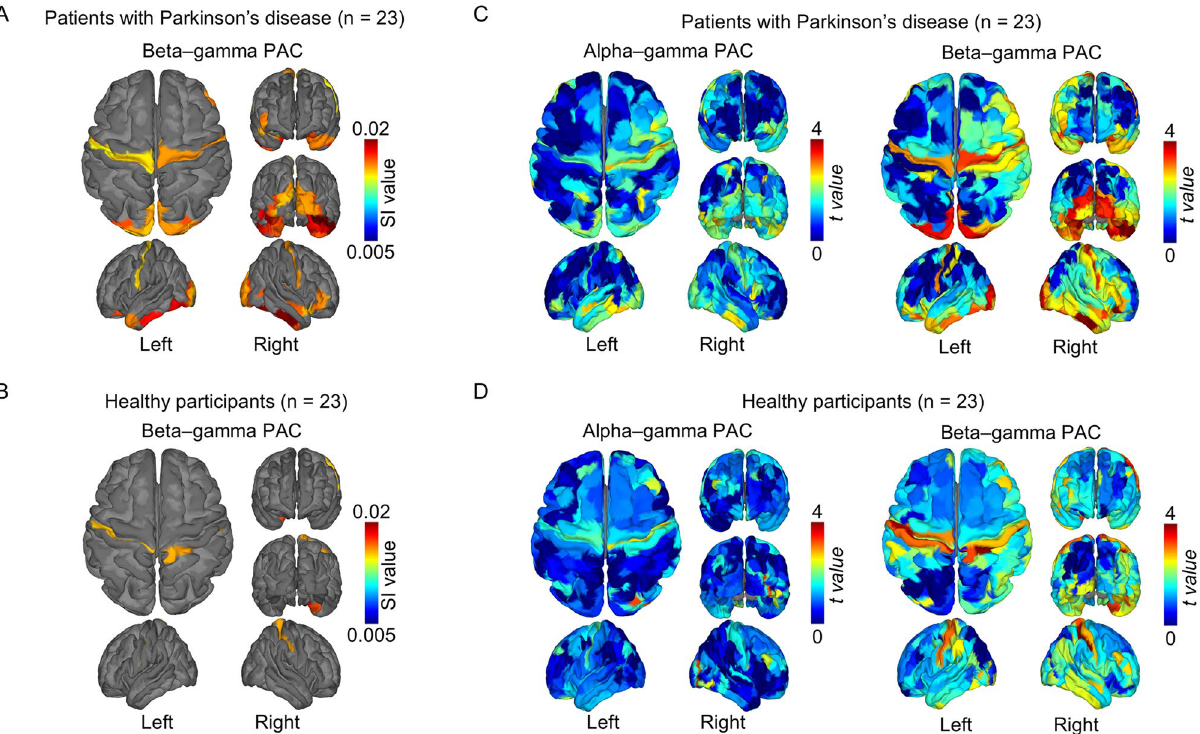
Figure 1. Beta–gamma phase-amplitude coupling during the resting state. For each study group (patients with Parkinson’s disease and healthy study participants), we averaged synchronization index (SI) values for beta–gamma coupling and color-coded them on the cortex of ( A ) patients (n = 23) and ( B ) healthy participants (n = 23). The SI values are shown only if they significantly exceeded the corresponding phase-shuffled values in (A) and (B). The t value s between SI values and phase-shuffled SI values are color-coded on the cortex of ( C ) patients (n = 23) and ( D ) healthy participants (n = 23) for alpha–gamma coupling and beta–gamma